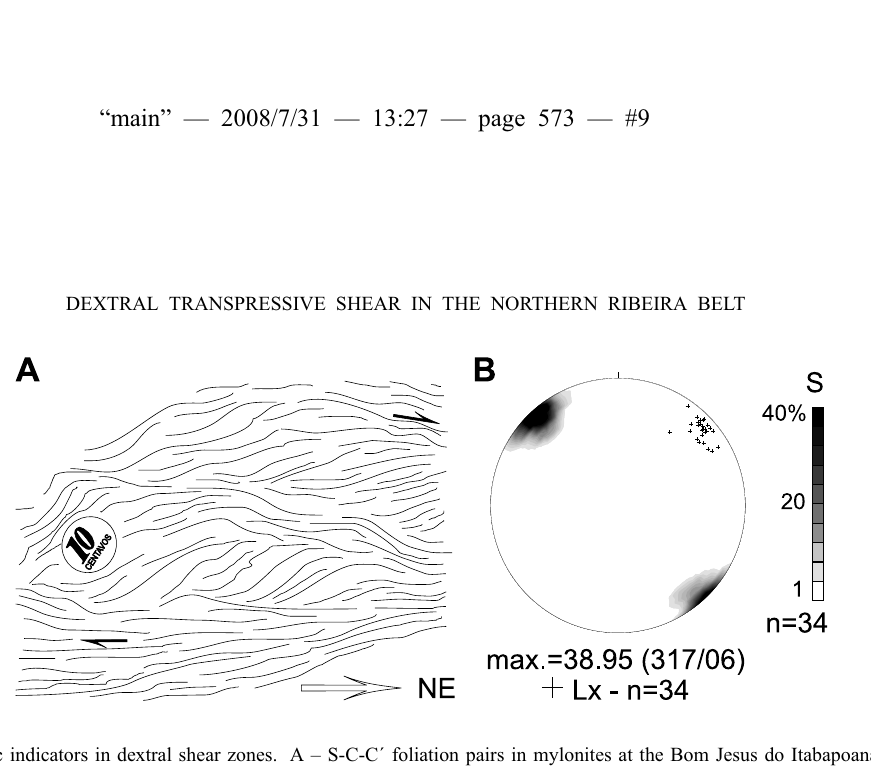
Fig. 9 – Kinematic indicators in dextral shear zones. A – S-C-C´ foliation pairs in mylonites at the Bom Jesus do Itabapoana road junction. Sections parallel to the XZ plane of the finite deformation ellipsoid, with its direction shown; B – Stereographic projection of foliation poles (S) and stretching and mineral lineations (Lx). Number of data points (n) shown.